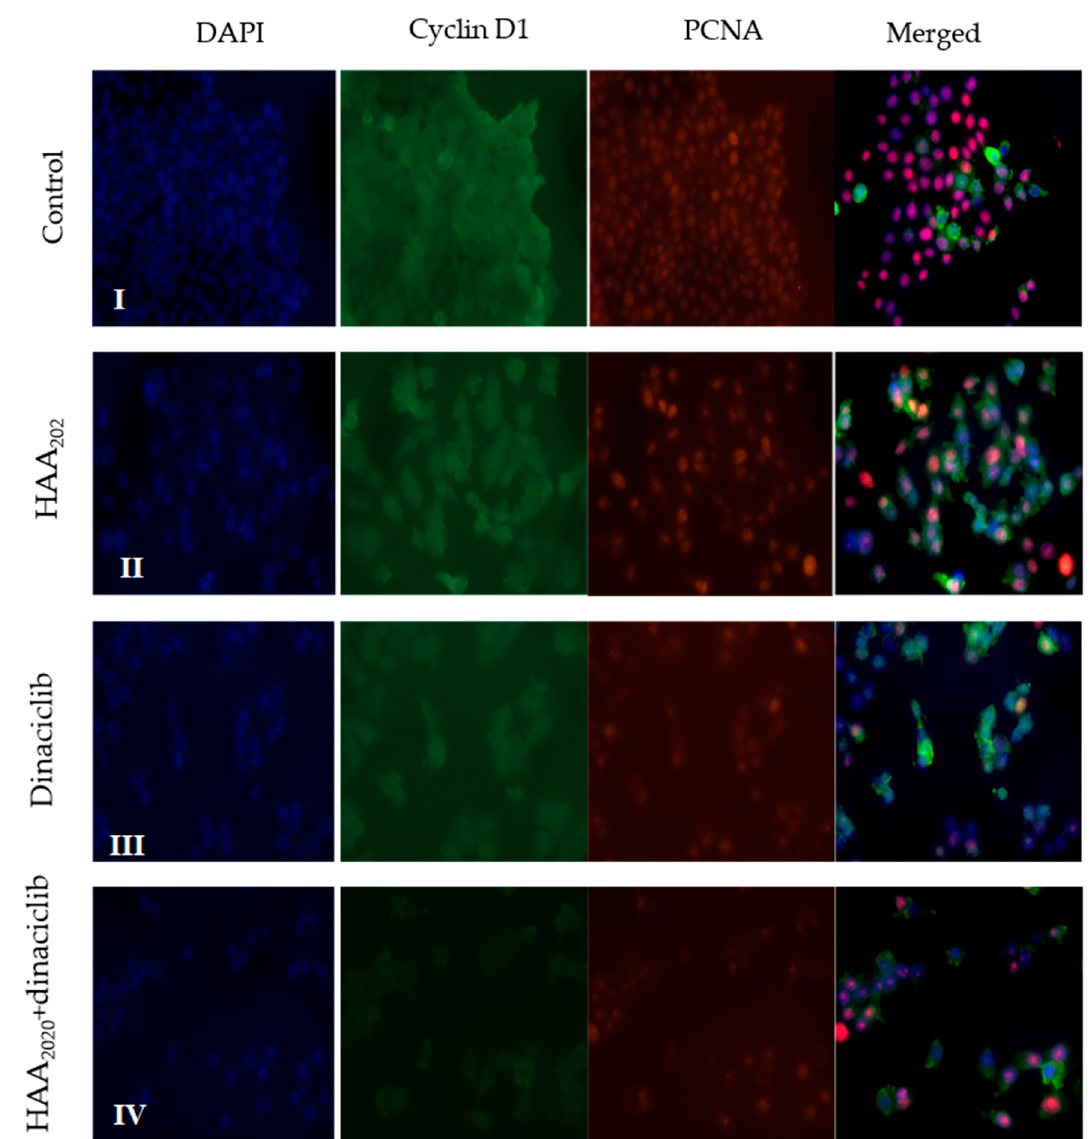
Figure 9. The co-localization of the immunofluorescent bodies using cyclin D1 (green) combined with PCNA (red), counterstained with DAPI (4‘,6-diamidino-2-phenylindole) in MCF7 cells (scale bar = 15 μ m; 40× objective). I : untreated control, II : cells treated with HAA 2020 , III : cells treated with dinaciclib, IV : cells treated with both HAA 2020 , dinaciclib.